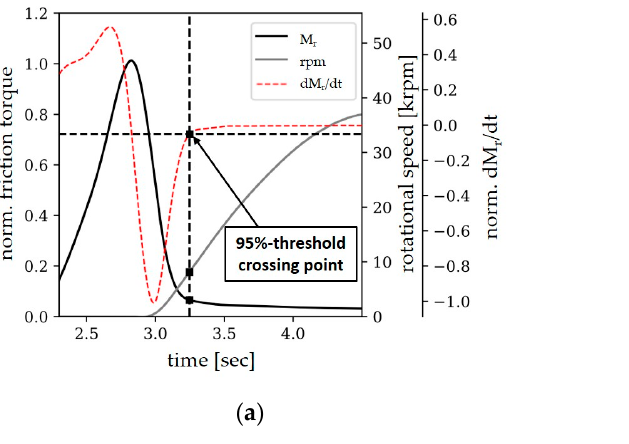
Figure 6. Test results from the friction torque measurements. Frictional torque (black line); rotational speed (gray line); time derivative of the frictional torque (red dashed line); ( a ) nom. clearance 105 µm static load: 10 N; ( b ) nom. clearance 25 µm static load: 70 N; (1 krpm = (100/3)π ⋅ rad/s).